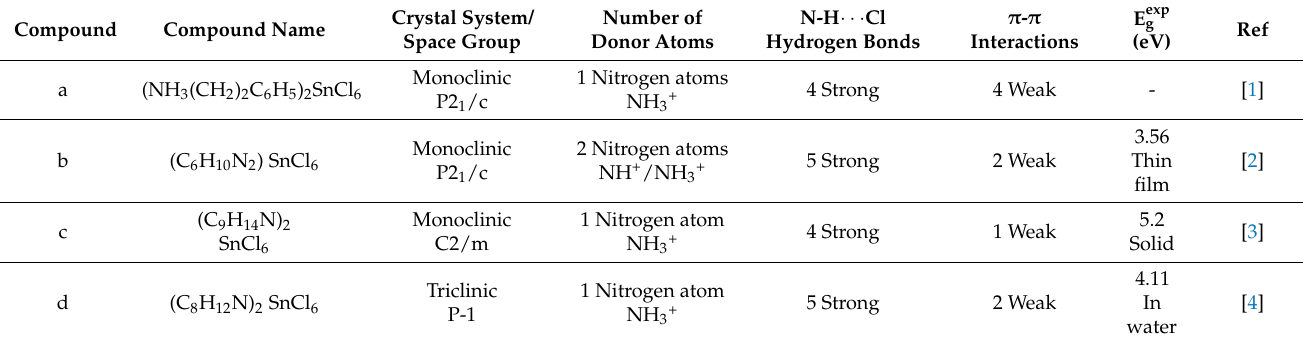
Table 1. Summary of the Van der Waals interactions in the different